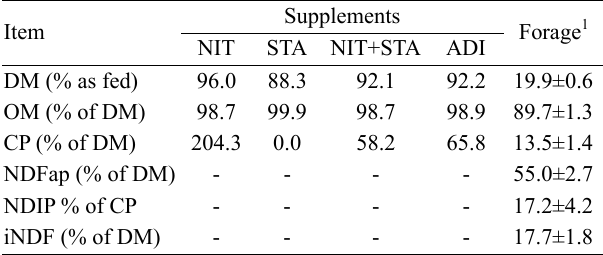
Table 1. Chemical composition of forage and